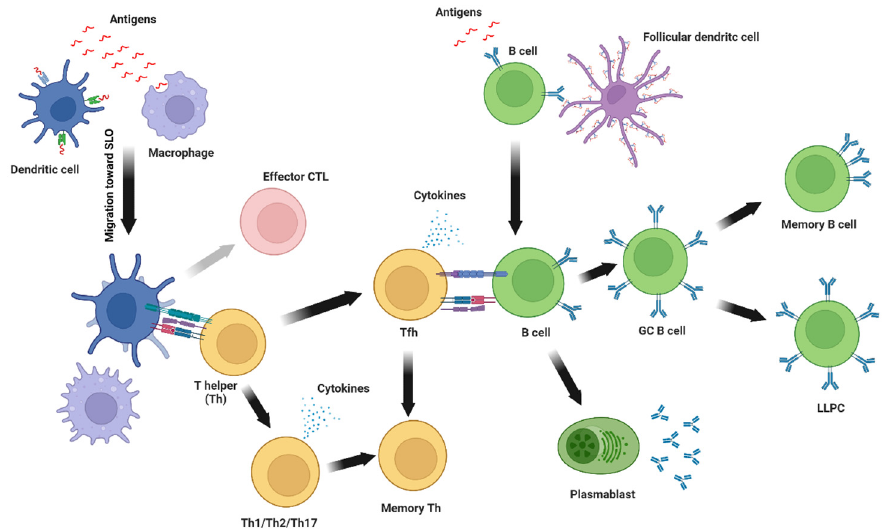
Figure 3. Immune response to subunit vaccines. In brief, antigen presenting cells, including den- dritic cells and macrophages, internalize antigens at the site of injection and migrate toward secondary lymphoid organs (SLO) where they present antigen-derived peptides loaded on major histocompatibility complex (MHC) molecules to T helper (Th) and cytotoxic T cells (CTL). Activated Th cellsproliferate and differentiate into Th1, Th2, or Th17 and secrete cytokines and modulate the activity of other immune cells. An activated T helper can also differentiate into T follicular helper (Tfh) which provides direct help for B cell activation and germinal center reaction. Following the contraction of the immune response, some activated T helpers remain as memory T helpers. On the other hand, CTL can be reactivated (grey arrow) following antigen presentation on MHC-I molecules. Simultaneously, antigen-specific B cells are activated by soluble or membrane-bound antigens immobilized on follicular dendritic cells. Activated B cells proliferate and then differentiate into plasmablasts that secrete low-avidity antibodies or become germinal center B cells (GC B cells) where their BCR undergoes somatic hypermutation to increase antibodies’ avidity. GC B cells then differentiate into long-lived plasma cells (LLPC) that constitutively secrete antibodies and reside in the bone marrow or memory B cells that patrol secondary lymphoid organs waiting for subsequent exposure to the same antigen.